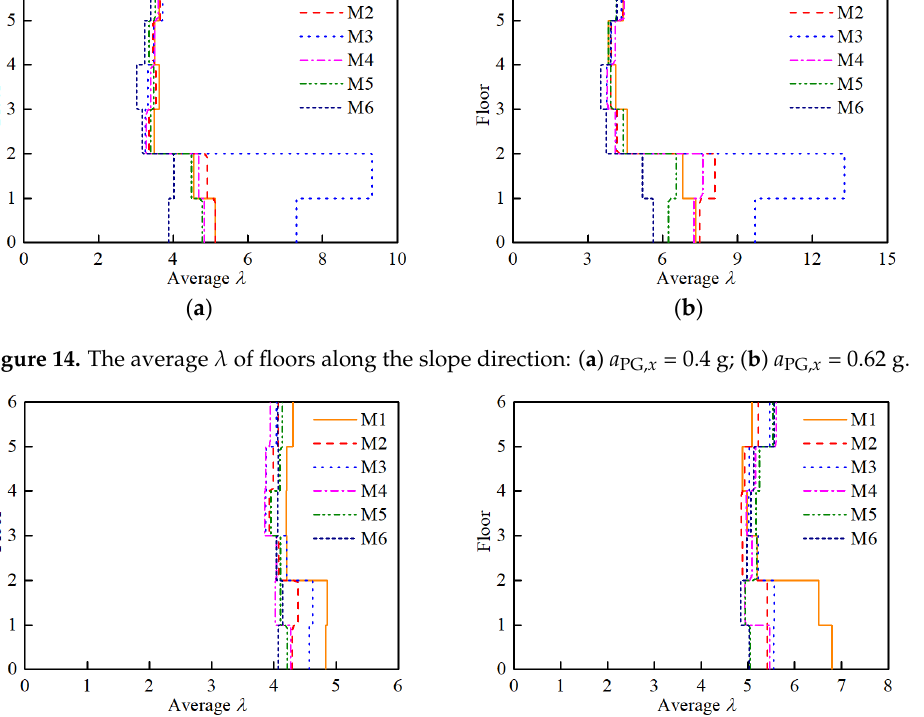
tion with the same seismic intensity, and the average 𝜆 tends to decrease as 𝛾 (cid:2919)(cid:2924)(cid:2930)(cid:2928)(cid:2911) in ‐ creases. When 𝛾 (cid:2919)(cid:2924)(cid:2930)(cid:2928)(cid:2911) increases to a certain extent, 𝜆 of floors under the upper embedding Figure 13. The average 𝜆 of lower ‐ embedding columns: ( a ) Along the slope direction; ( b ) Across end is close to that of the floors above the upper embedding end. the slope direction. slope direction.